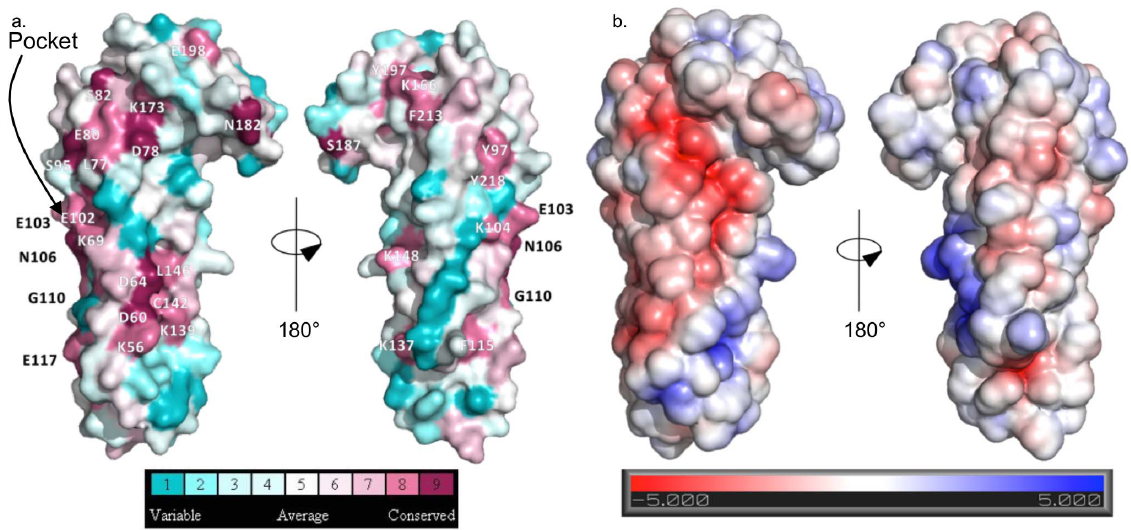
Figure 3. Surface of Pb SPECT1 D 41. a . Residues conserved among homologs of Pb SPECT1 were mapped to the molecular surface of Pb SPECT1 D 41. Two views of Pb SPECT1 related by a 180 ˚ rotation around the indicated axis are shown. Color scale for conservation is shown at bottom. b . The electrostatic surface mapped to the van der Waals surface of Pb SPECT1 D 41 is shown. As in panel a, two views and a color scale are shown.